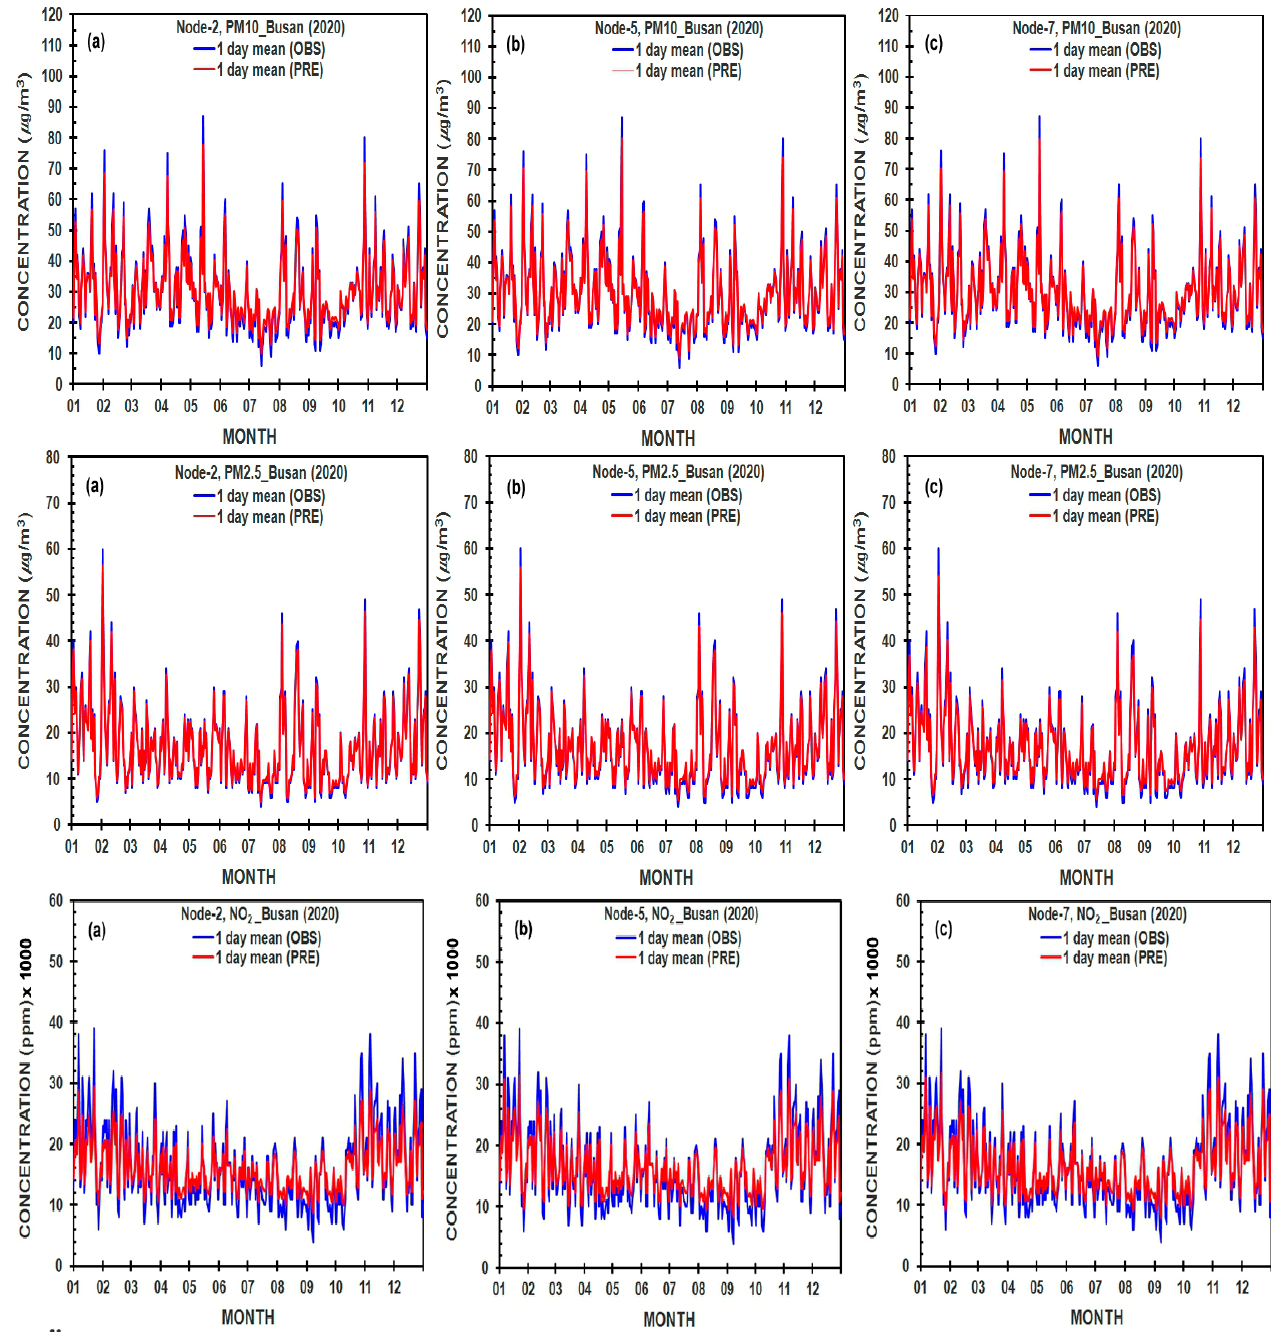
Figure 7. As shown in Figure 6, except for Busan city, Korea.